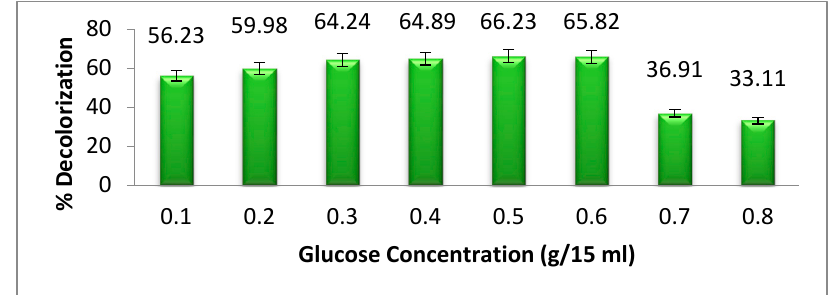
Figure 6. Degradation of methyl orange at different glucose concentration.